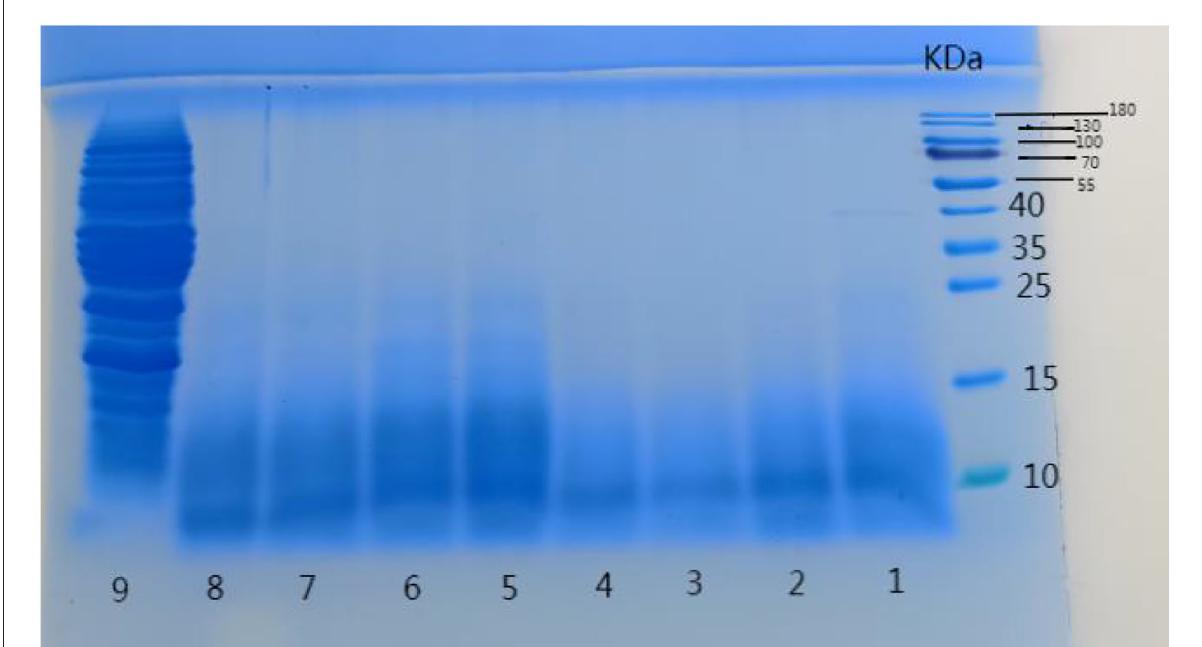
FIGURE3 Polyacrylamide gel electrophoresis with sodium dodecyl sulfate for the fermentation of peptides from 8 strains, different swimming lanes indicate chickpea peptides fermented by different strains. Lane 1: Bifidobacterium species , lane 2: Lactobacillus acidophilus , lane 3: